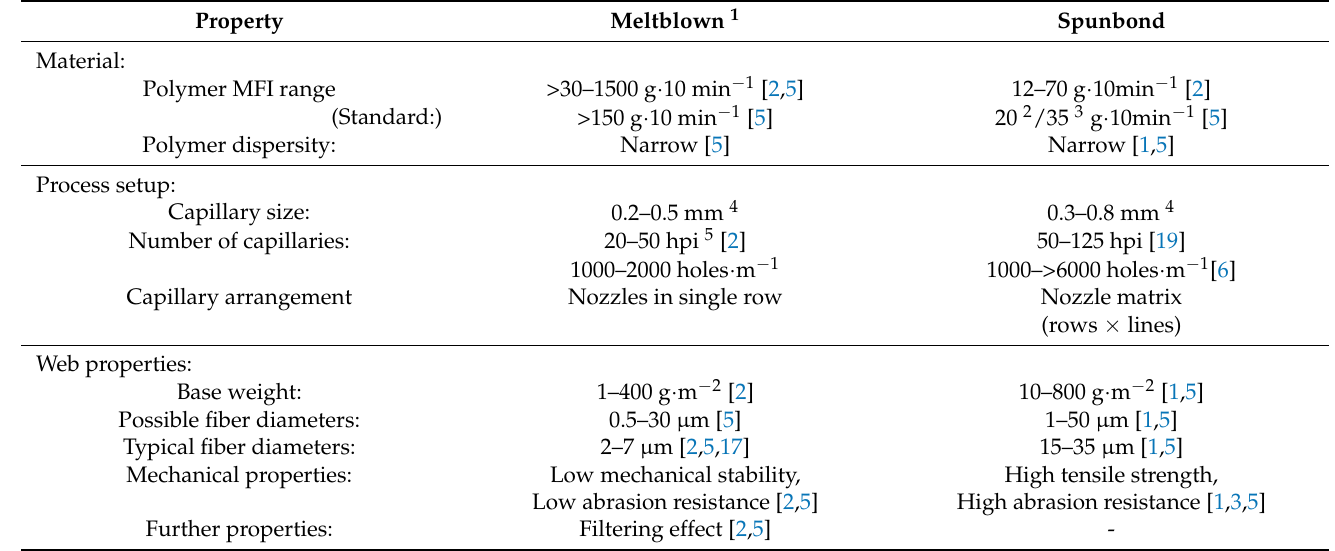
Table 1. Process specific material properties, process set-up specifications, and typical properties of meltblown and